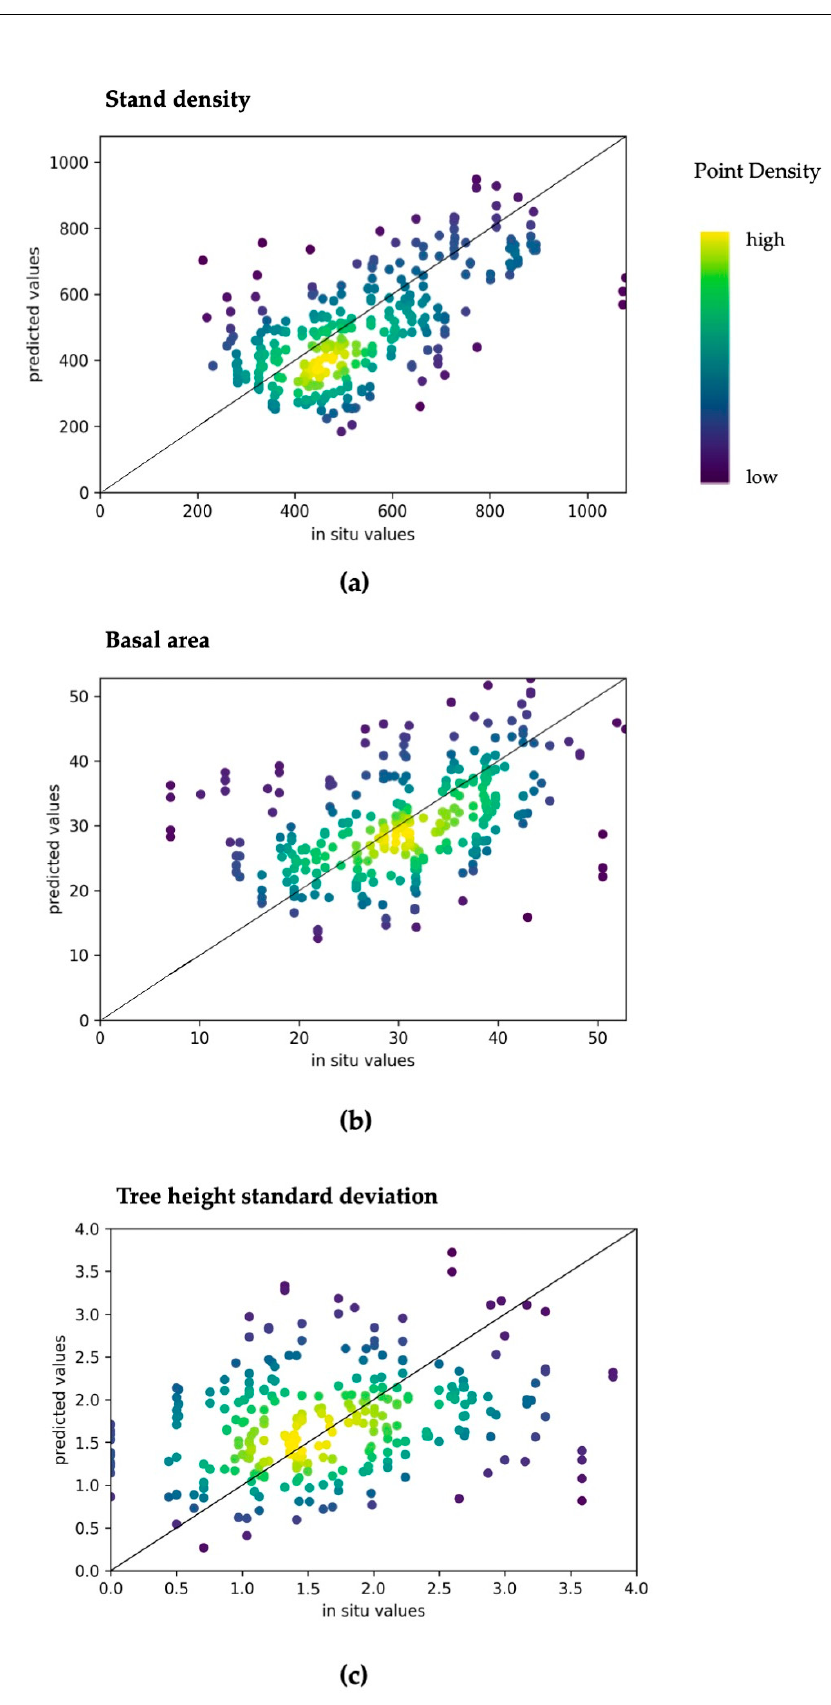
Figure 10. Density scatterplots of ( a ) stand density index; ( b ) tree basal area (m); ( c ) tree height standard deviation (m). Predictions are based on the model that includes both Sentinel-1 and Sentinel-2 metrics.